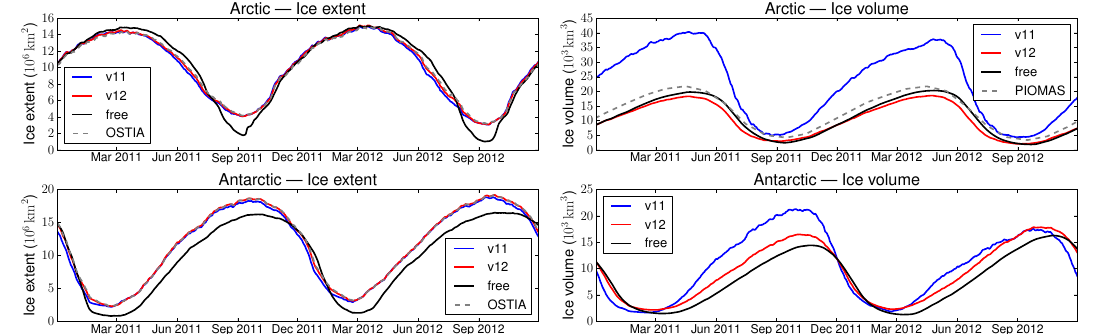
Figure 4. Time series of Arctic (upper) and Antarctic (lower) sea ice extent (left; 10 6 km 2 ) and volume (right; 10 3 km 3 ) derived from the v12 (red), v11 (blue) and free (black) trials. Daily OSTIA (Donlon et al., 2012) sea ice extent derived from OSI-SAF ice concentrations and monthly PIOMAS (Schweiger et al., 2011) sea ice volume (Northern Hemisphere only) are plotted as grey dashed lines. Table 3. Percentage reduction in RMS error for the v12 trial rela- tive to the v11 trial calculated separately for areas of high and low mesoscale variability in the extra-tropics from 23 ◦ – 66 ◦ latitude. The variability threshold used is based on the standard deviation of SLA observations with σ = 0 . 11m . The proportion of the extra- tropical ocean surface classified as either high or low variability us- ing this threshold can be seen in the bottom row of the table.